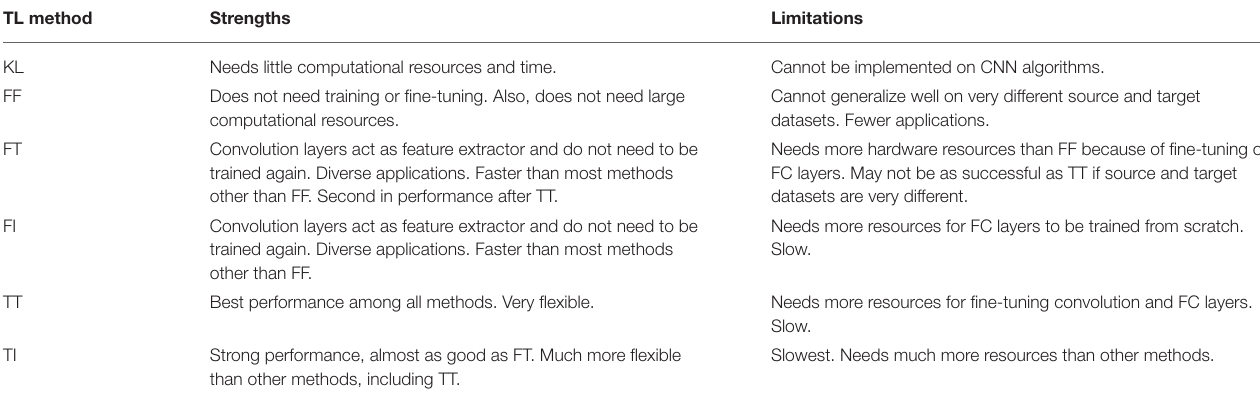
TABLE 7 | Strength and limitations of transfer learning approaches. TL